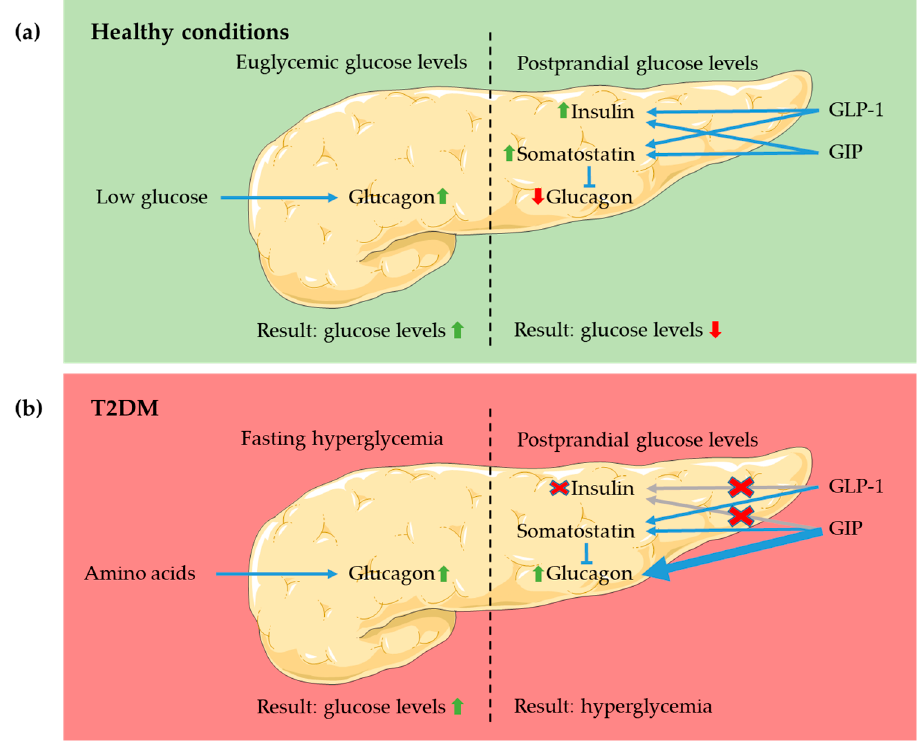
Figure 1. Actions of GLP-1 and GIP in the pancreas. The diagram shows the actions of the incretins under fasting and postprandial glucose levels in ( a ) healthy individuals and ( b ) patients with type 2 diabetes mellitus